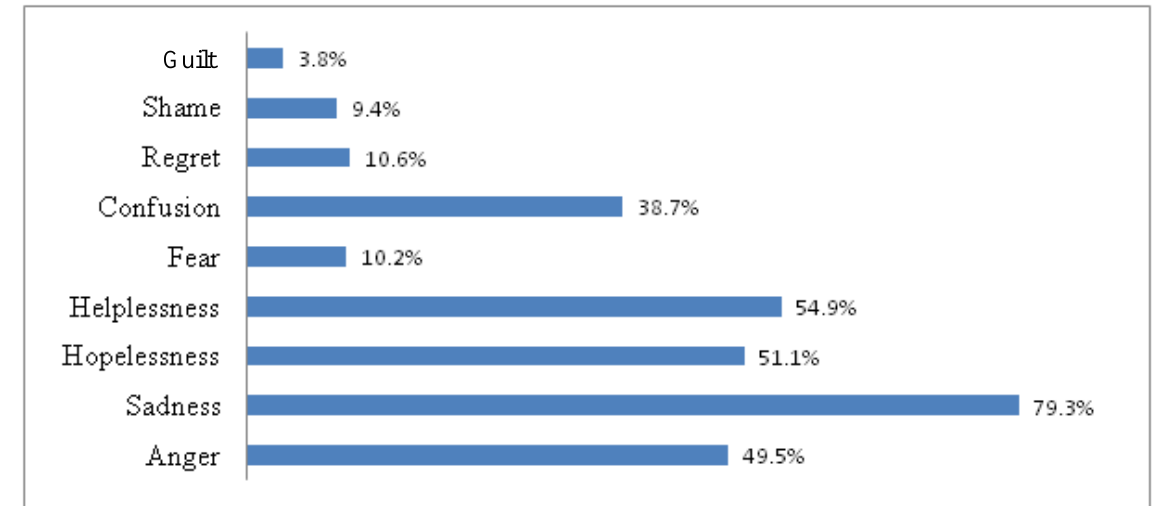
Figure 1. Feelings at the time of